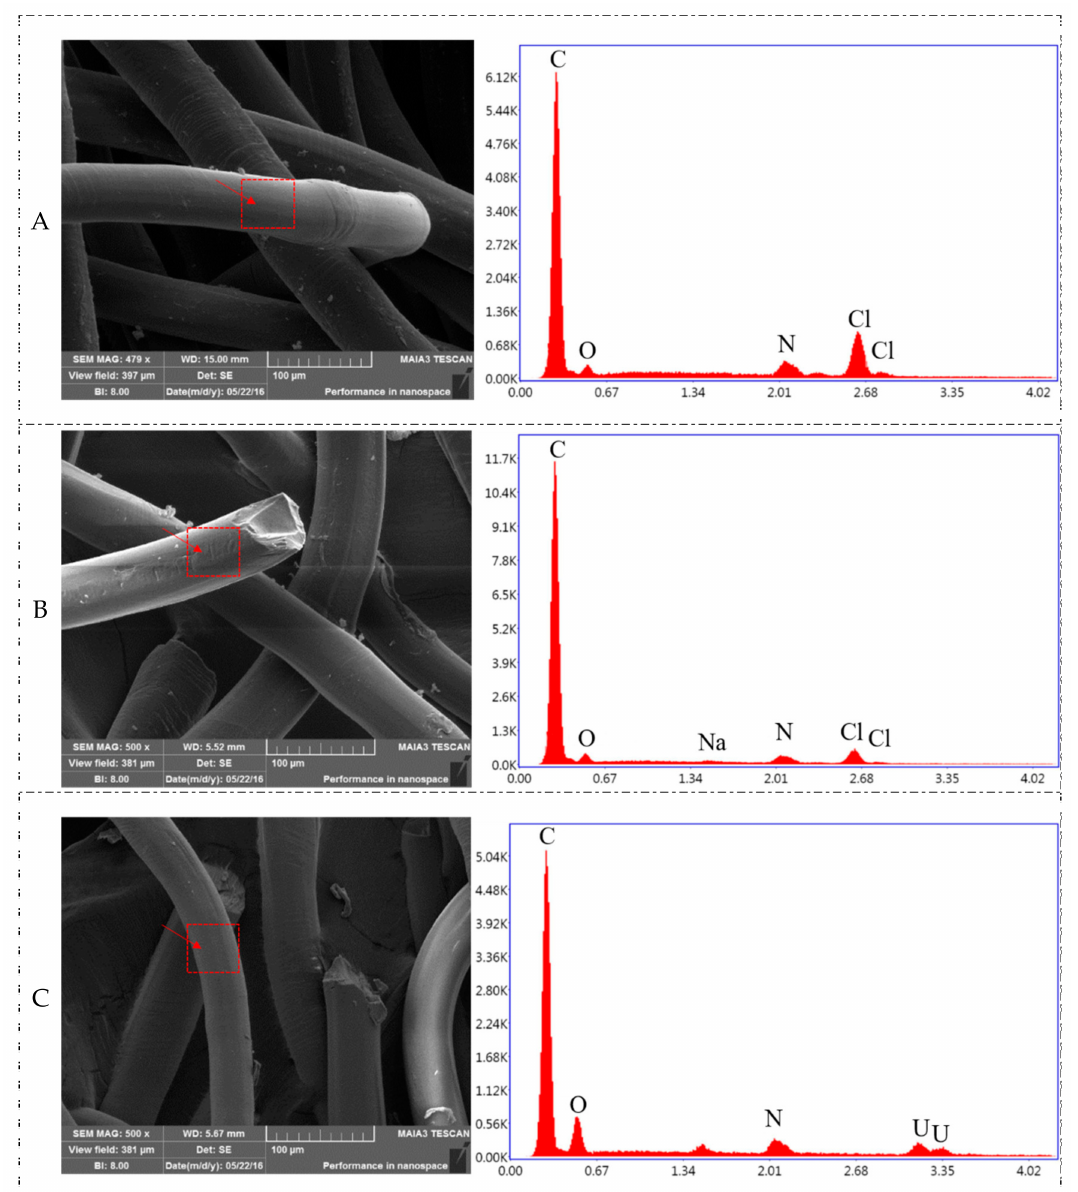
Figure 2. The SEM and EDS diagrams (( A ): original fibers; ( B ): prepared fibers; ( C ): adsorption of uranium